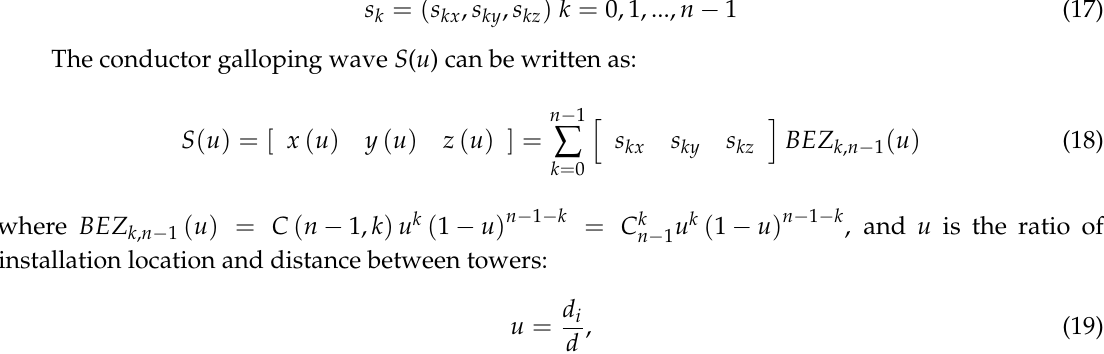
Figure 11. Y-axes accelerations with respect to the geographical coordinate frame.